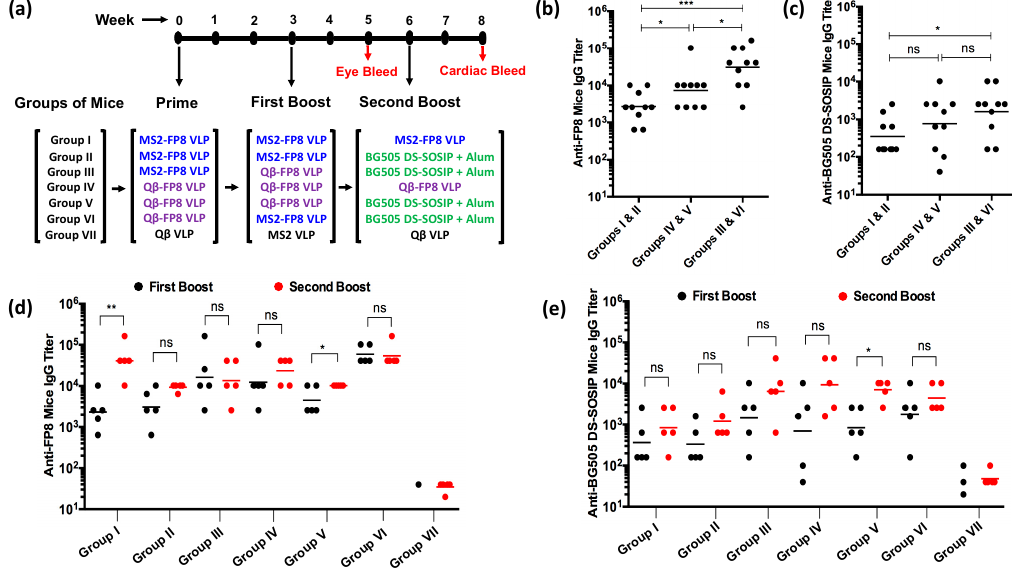
Figure 4. Immune responses in mice vaccinated with FP8-VLPs. ( a ) Immunization regimen. Groups of 5 mice were given three immunizations with FP8-VLPs (Groups I-VI) or control VLPs (Group VII). Mice were immunized at weeks 0 (prime), 3 (first boost), and 6 (second boost). At the second boost, some groups were immunized with native HIV-1 trimer (BG505 DS-SOSIP) plus Alum adjuvant. Serum collections occurred two weeks after the first boost [week 5] and the second boost [week 8]. Evaluation of the e ff ect of homologous vs heterologous prime-boost regimen on the level of ( b ) FP8- and ( c ) full-length HIV-1 Envelope trimer (BG505 DS-SOSIP)-specific total IgG titers, which were measured by ELISA using week 5 immune sera. Data were combined for each MS2-FP8VLP, Q β -FP8 VLP homologous-, and MS2-FP8 VLP / Q β -FP8 VLP heterologous-prime boosting immunizations. Each dot represents the IgG titer from a single mouse. Lines represent geometric means (n = 10 per group). p values were calculated by unpaired two-tailed t test. *, p < 0.05, **, p < 0.01, ***, p < 0.001. ( d ) Anti-FP8 and ( e ) Anti-BG505 DS-SOSIP IgG end-point dilution antibody titers after the first boost (black dots) and second boost (red dots) were measured by ELISA analysis of sera. Lines represent geometric means (n = 5 per group). Statistical analysis of antibody titers after the first and second boost is presented. * p < 0.05 and ** p < 0.01 indicate that there is a significant di ff erence between the antibody titers of each group after the first and second boost, ns indicates no significant di ff erence.